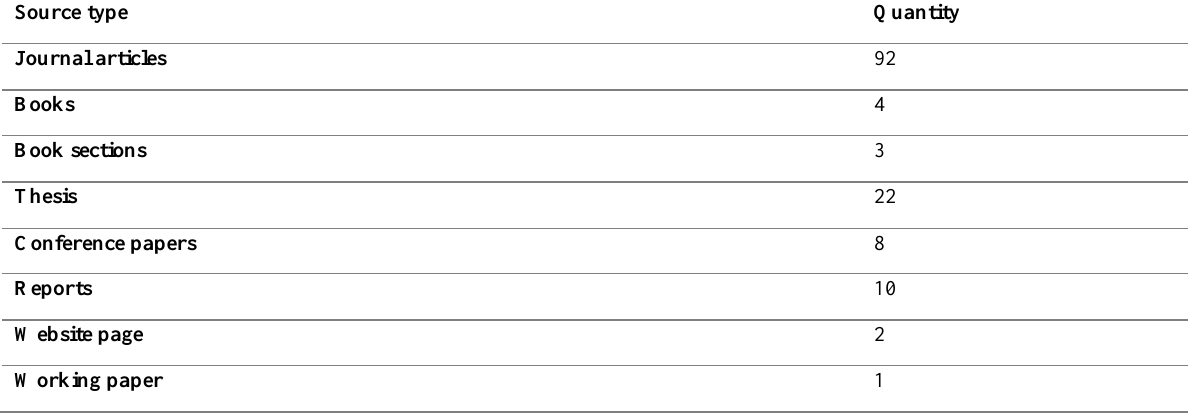
Table 1: Summary of literature sources